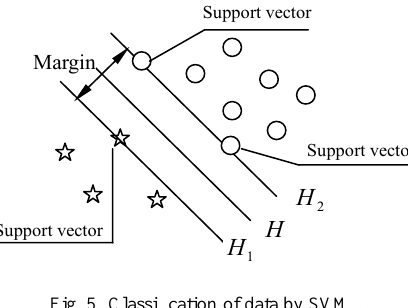
Fig. 5. Classification of data by SVM